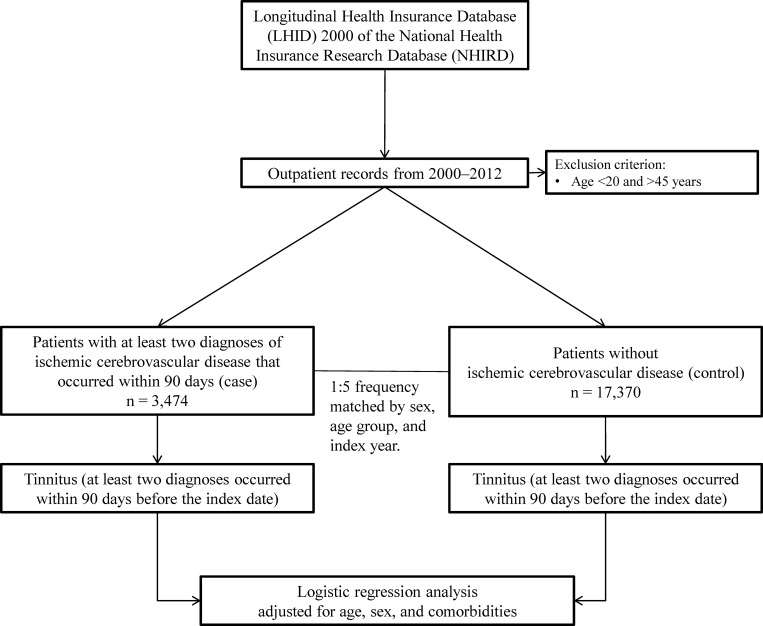
Study flowchart.